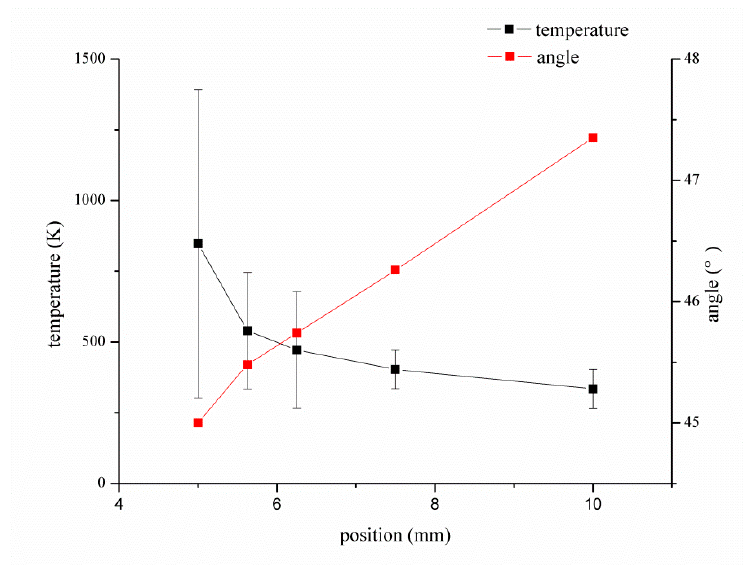
Figure 5. Temperature and angle variations at injection point.